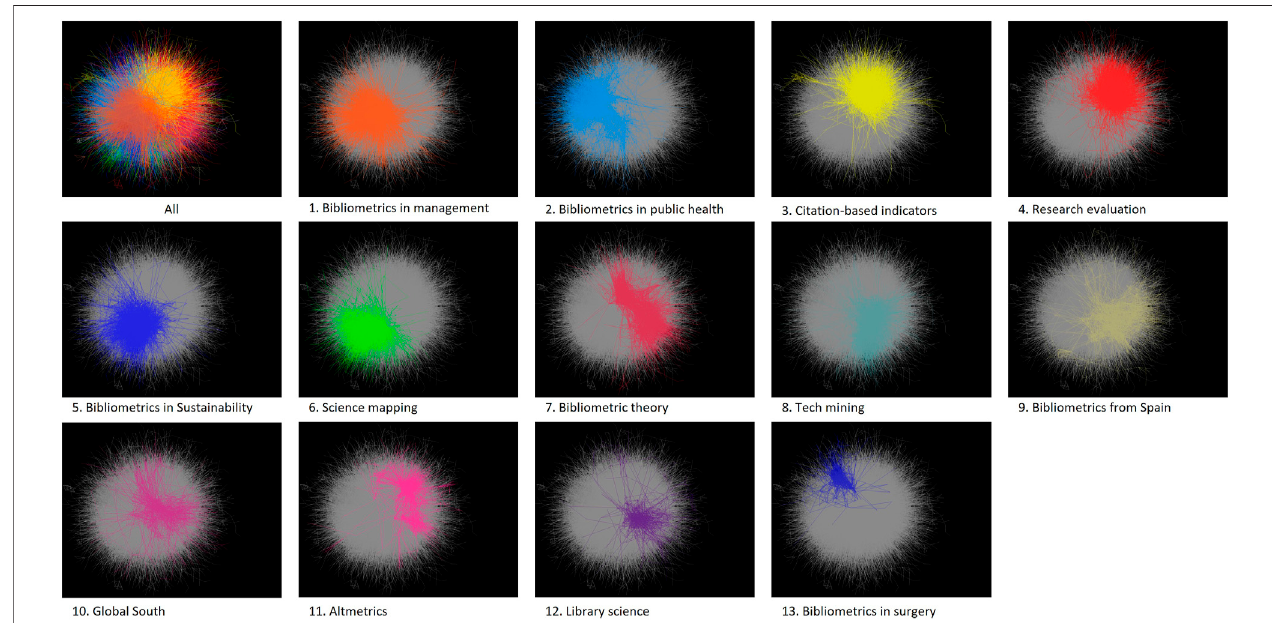
FIGURE 4 | Citation network of bibliometric research showing the relative position of the 13 clusters identi fi ed.